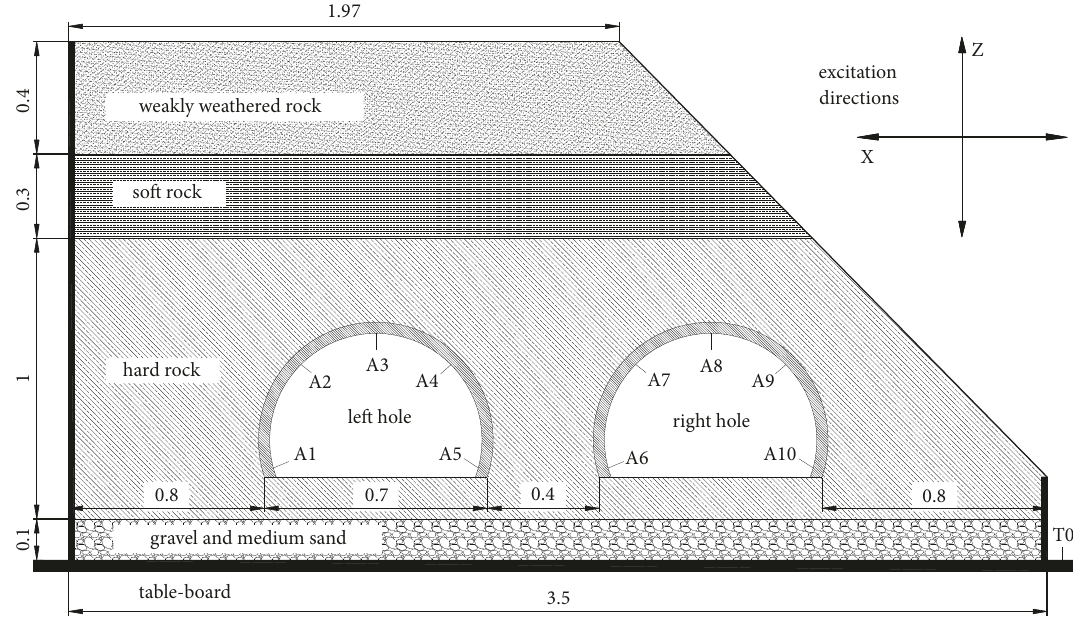
table-board Figure 4: Surrounding rock and layout of transducers (unit: